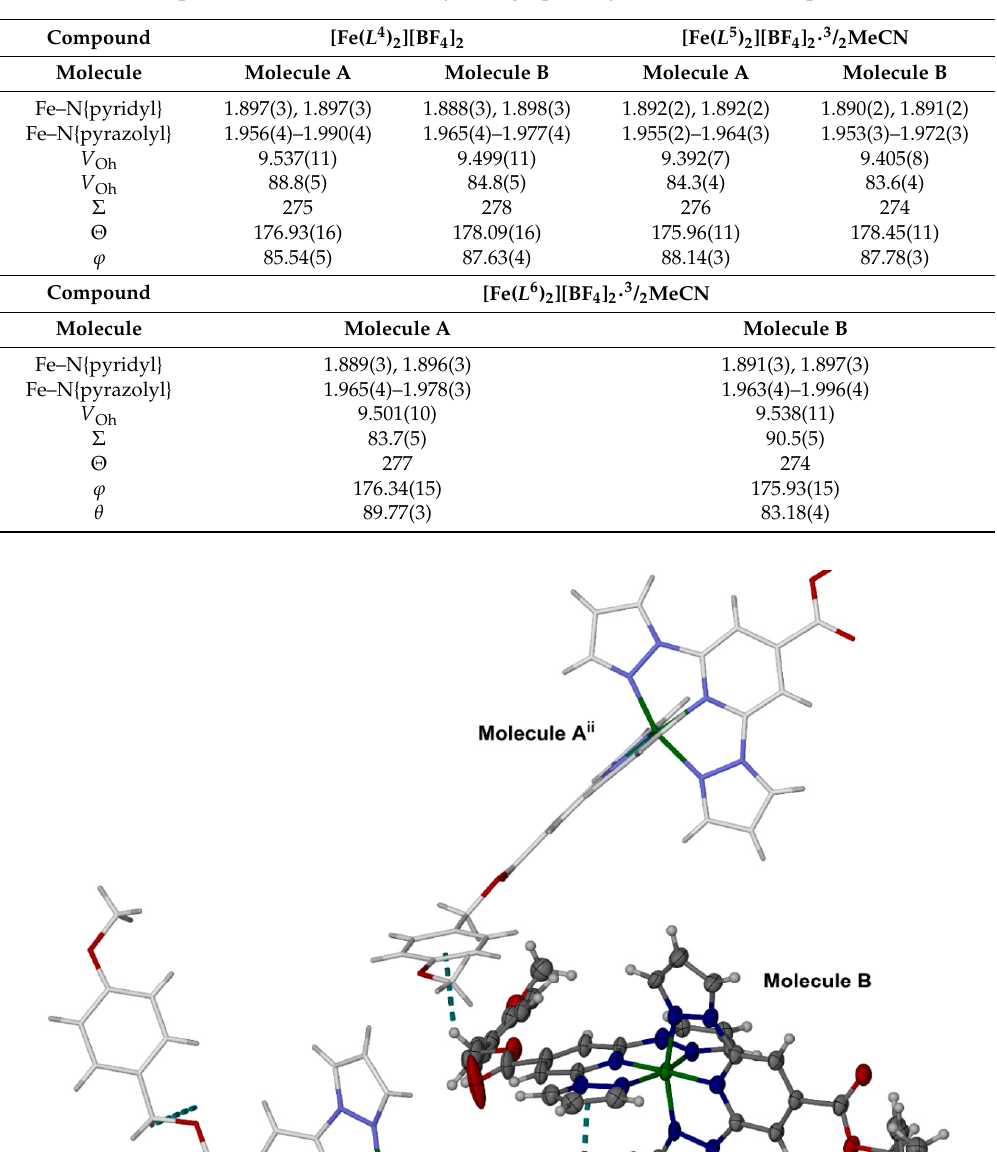
Table 2. Metric parameters for the other crystallographically characterised complexes (Å, Å 3 , º).